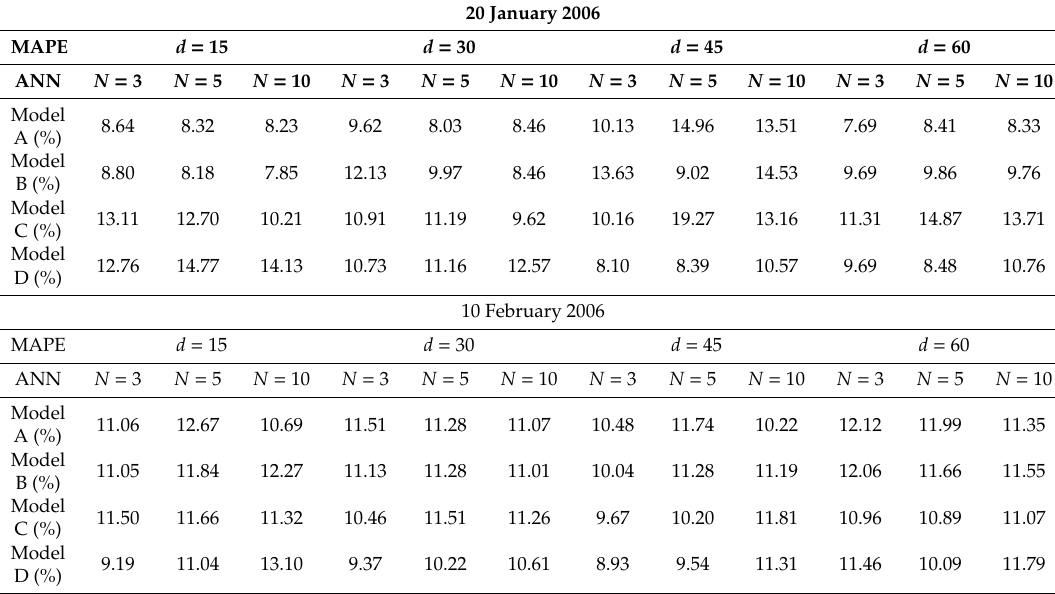
Table 2. Regression model price forecast of